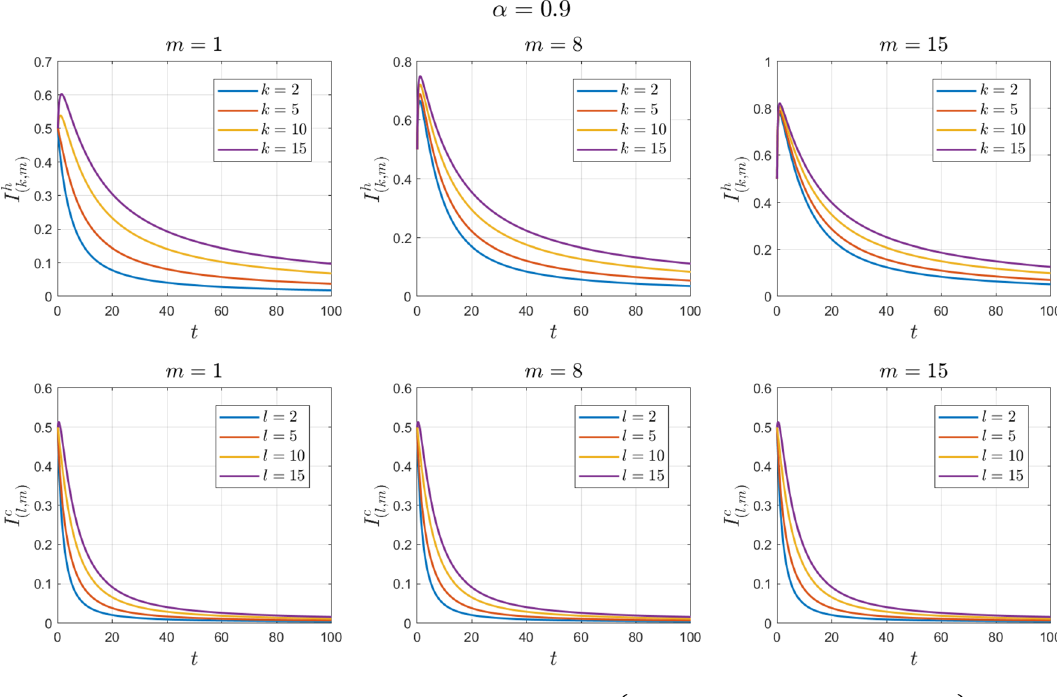
Figure 9. Numerical solutions of Example 4 for α = 0.9 with { 0.5, 0.5, 0.5, 0.5 }